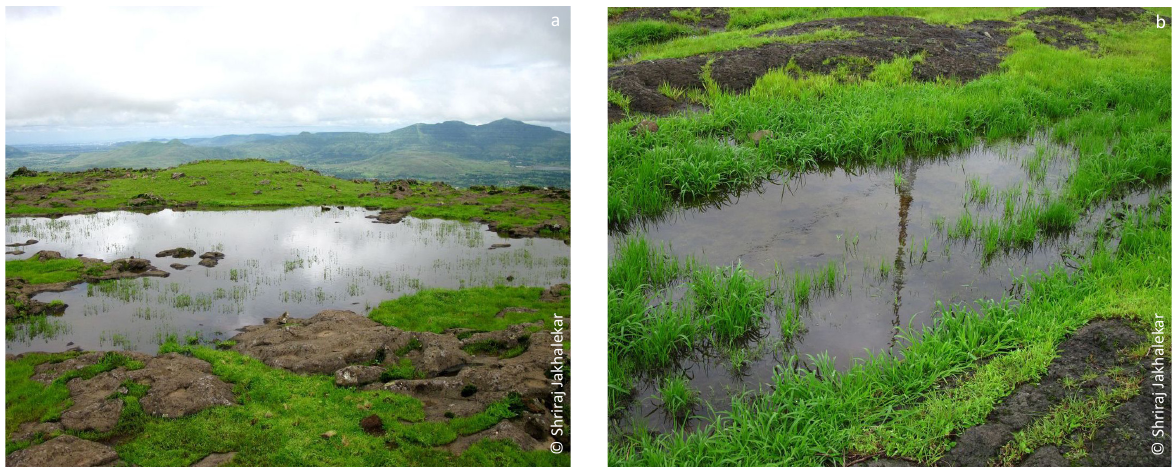
Image 1. (a) Pool from Visapur Fort, (b) Pool from Tableland